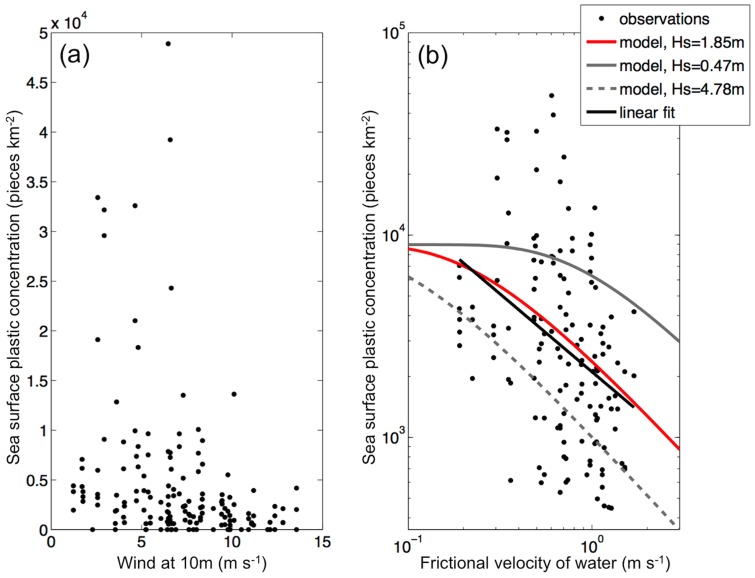
Sea surface plastic concentration (Cs) versus a) wind speed (U10) and b) water friction velocity (u*w).In (b) we also show the linear fit (Cs = a (u*w)b) and theoretical model estimates for Cs, when depth-integrated plastic concentration (Ci) is equal to 8966 (mean Ci of the 171 net tows) and significant wave height (Hs) is equal to the mean (1.85 m), maximum (4.78 m) and minimum (0.47 m) values estimated for the 57 net stations.